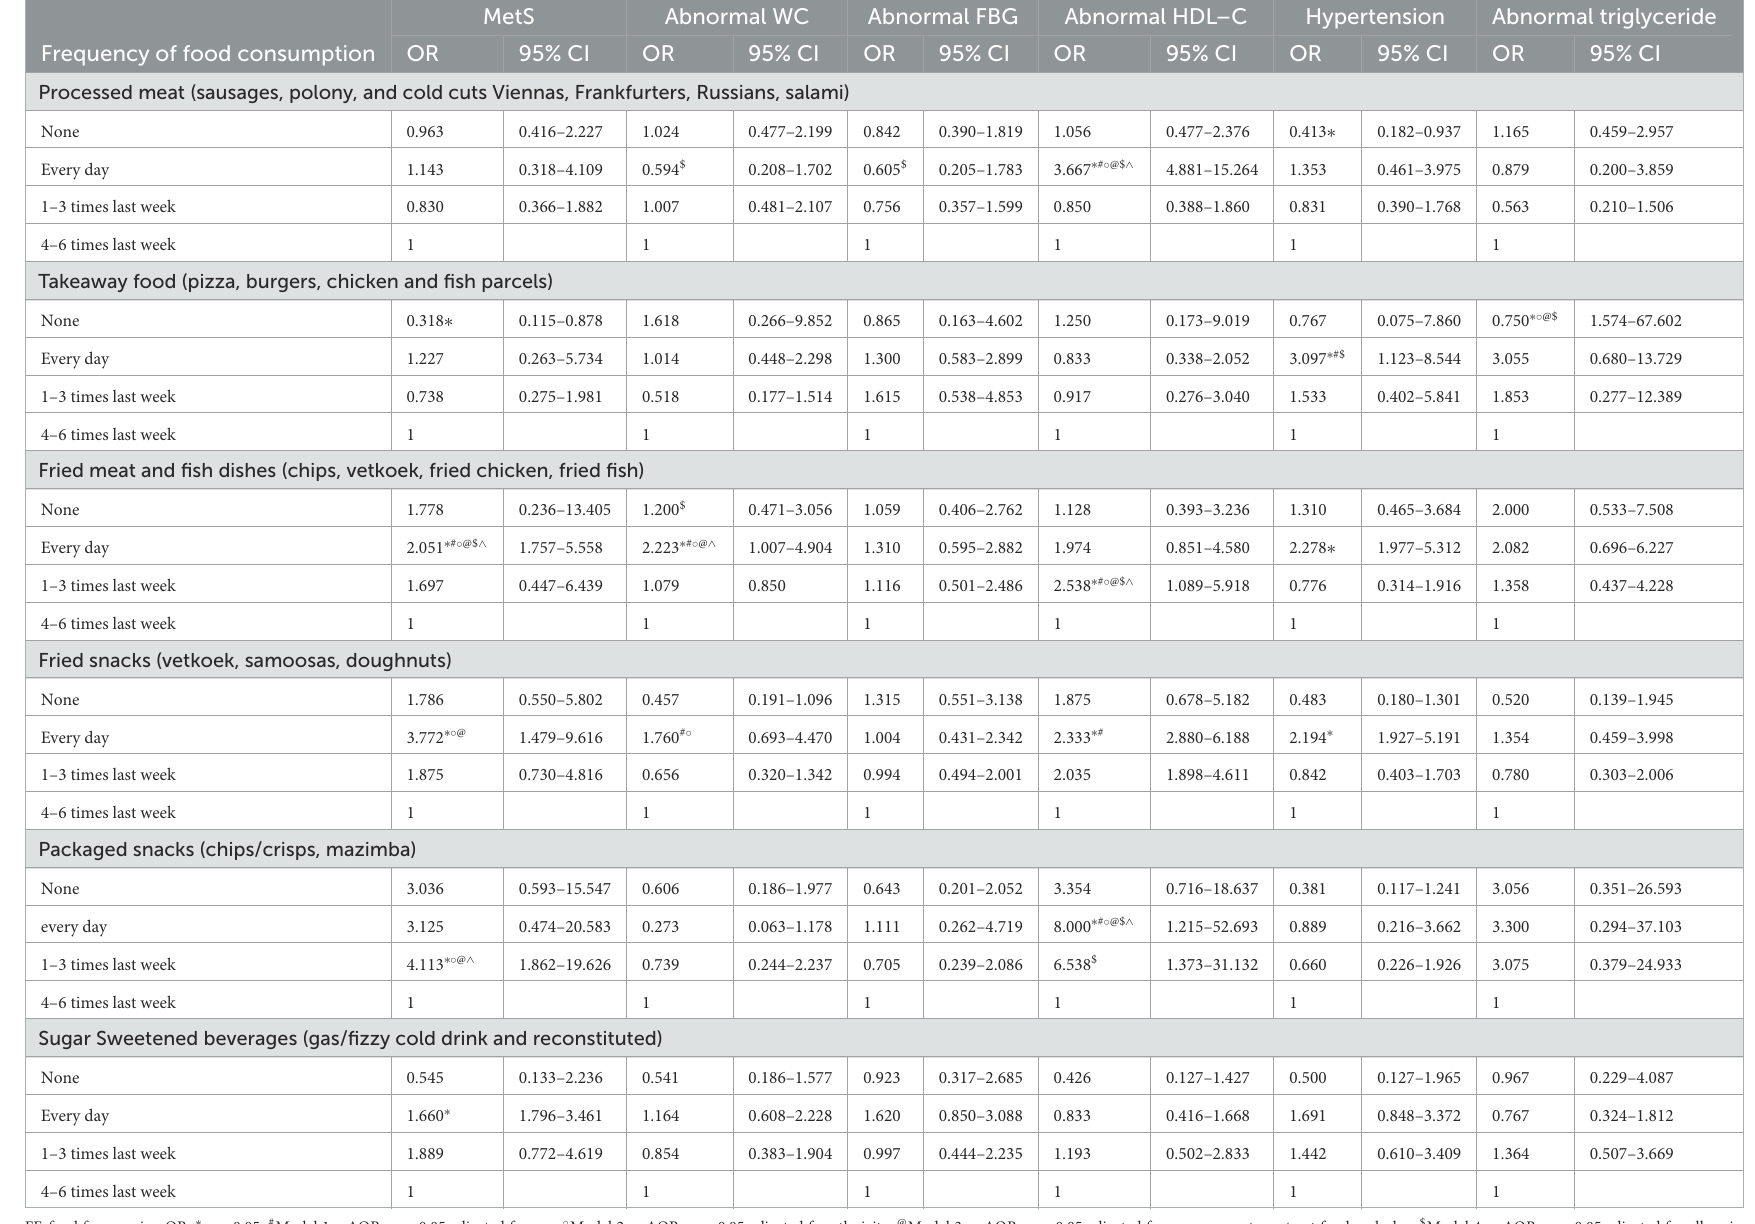
TABLE 7 The logistic regression analysis to show the association between the street foods consumed by the South African minibus taxi drivers and their MetS